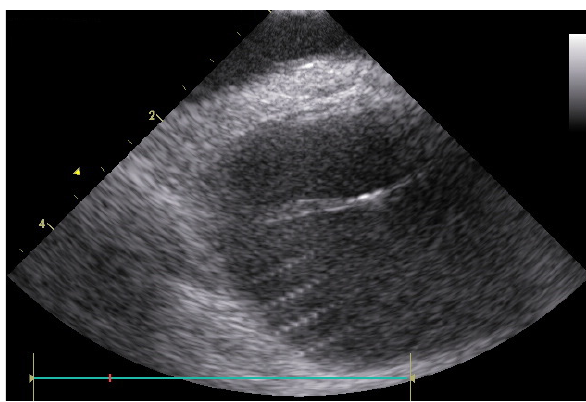
Fig. 3. Cardiac computed tomography. A chord-like structure in the left atrium.